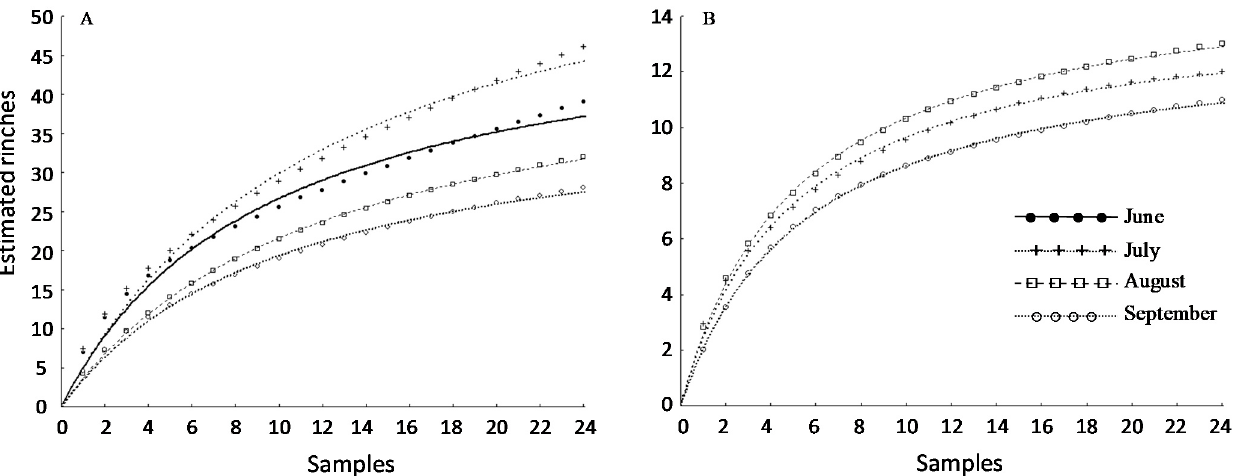
Figure 5. ( A ) Accumulation curves of estimated richness for morphospecies of arthropods and ( B ) plant species. Each mark ( ● , +, □ , and ○ ) represents the mean of 500 randomizations in the months of study. Lines represent the estimated taxa accumulation.